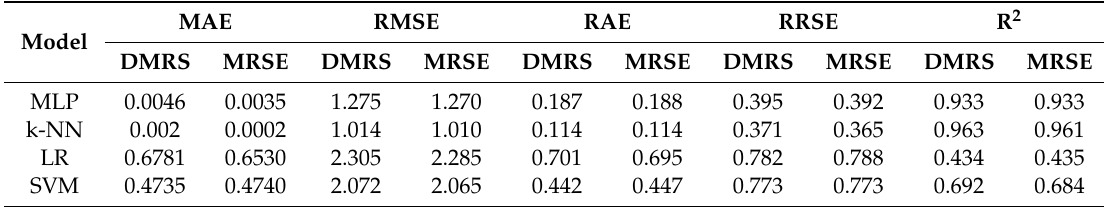
Table 2. Key performance indices based on plane (DMRS) and space (MRSE) figures of merit. Model